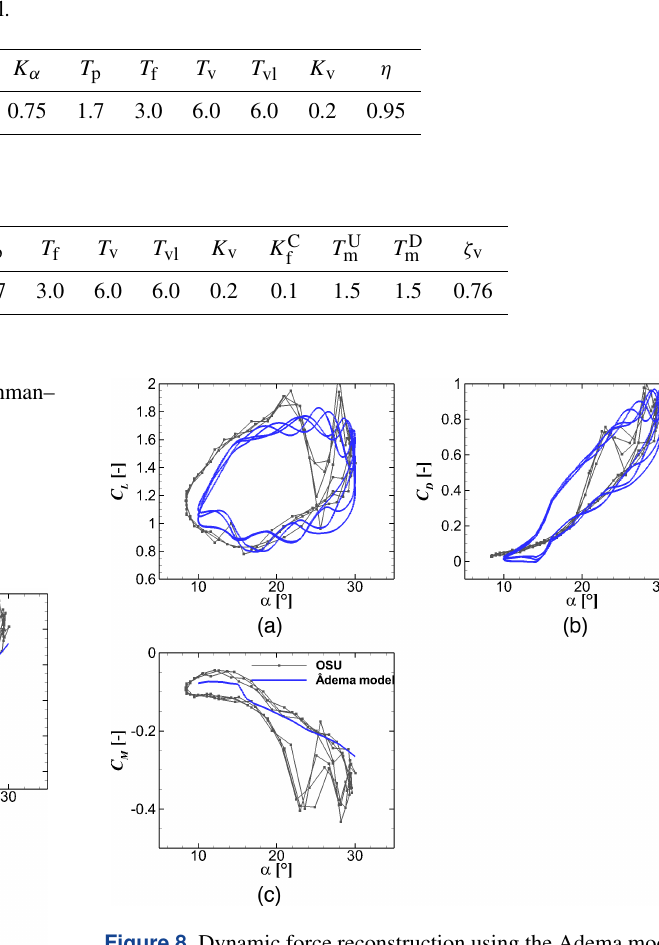
Figure 8. Dynamic force reconstruction using the Adema model in comparison with the measurement data (Ramsay et al., 1996) for (cid:49)t = T/ 1440. S801 airfoil, k = 0 . 073, α = 20 ◦ and (cid:49)α = 10 ◦